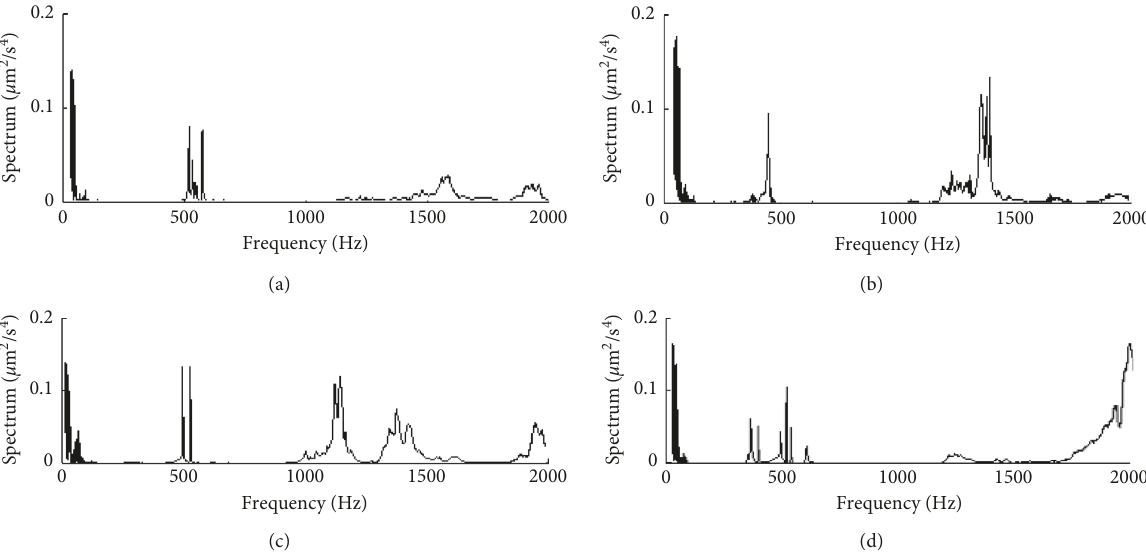
Figure 15: Tangential FFT spectrogram. (a) Case 1, (b) case 2, (c) case 3, and (d) case 4.